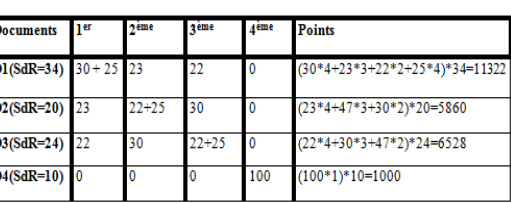
TABLE II. S CORE